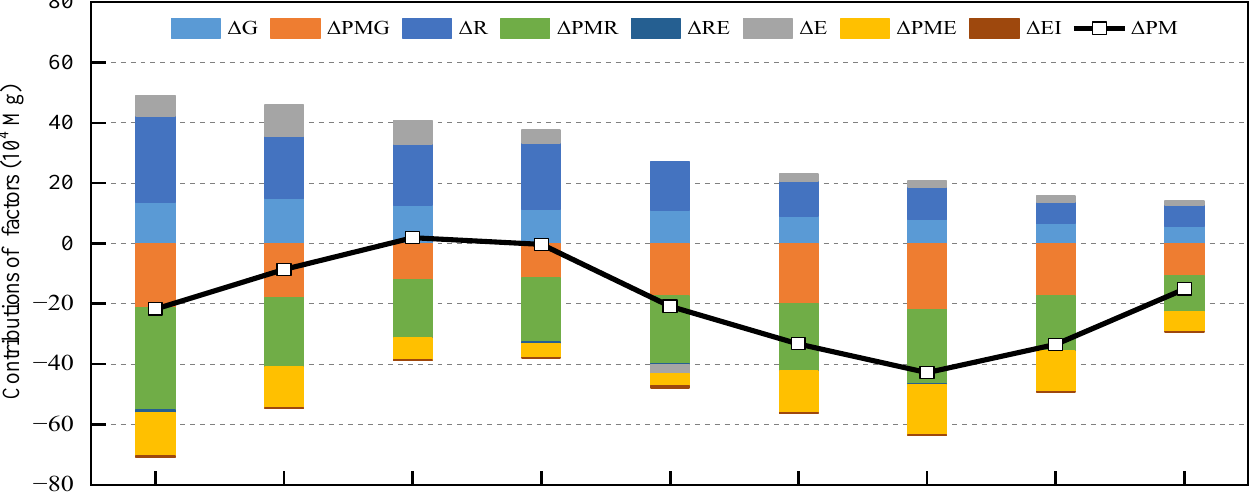
Figure A1. Decomposition results in Eastern China from 2008 to 2017 ( ∆ G , ∆ PMG , ∆ R , ∆ PMR , ∆ RE , ∆ E , ∆ PME and ∆ EI denote the effects of changes in GDP, emission intensity, innovation input scale, innovation input PM 2.5 intensity, innovation input efficiency, energy consumption scale, emission coefficient, and energy intensity on the changes in PM 2.5 emissions, respectively. ∆ PM indicates the changes in PM 2.5 emissions).